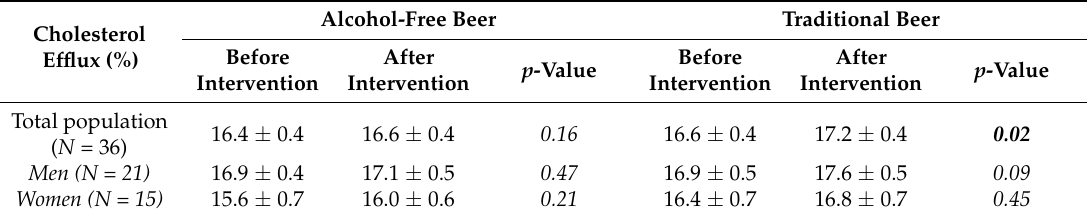
Table 6. Effect of the intervention with alcohol-free and traditional beer on the cholesterol efflux induced by apoB-depleted serum in macrophages.